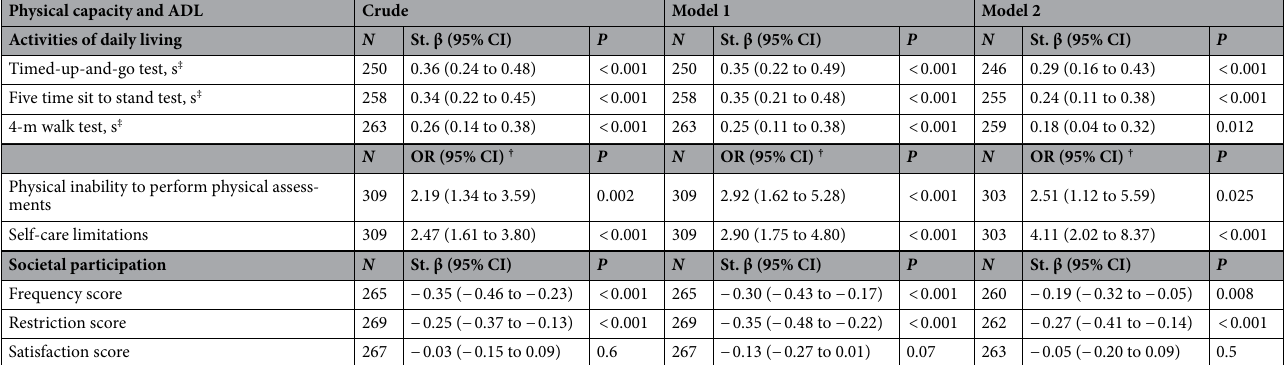
Table 2. Results of regression analyses with hand dexterity as independent variable and measures of daily functioning as dependent variable. Model 1: adjusted for age and sex. Model 2: model 1 additionally adjusted for educational level, body mass index, diabetes, dialysis before transplantation, time since transplantation, hemoglobin, C-reactive protein and plasma albumin. † : Per 5 s increment of the hand dexterity test. ‡ : Reasons for not performing the physical assessments were an inability to walk safely or walking caused too much pain ( n = 14), or because of time constraints ( n = 28). Results are presented in standardized beta (st. β) coefficients for linear regression analyses and in odds ratios (OR) for logistic regression analyses, with 95% confidence intervals